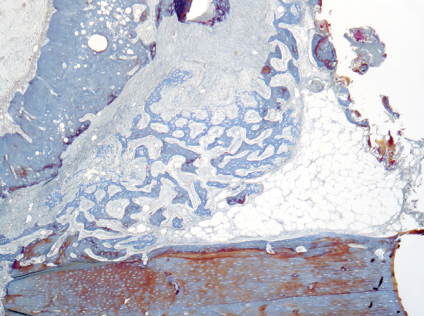
Figure 6: Histotopogram of the rabbit’s mandible cross section 2 weeks after the formation of a bone defect and introduction of calcium hydroxide suspension with nanodispersed cerium dioxide.